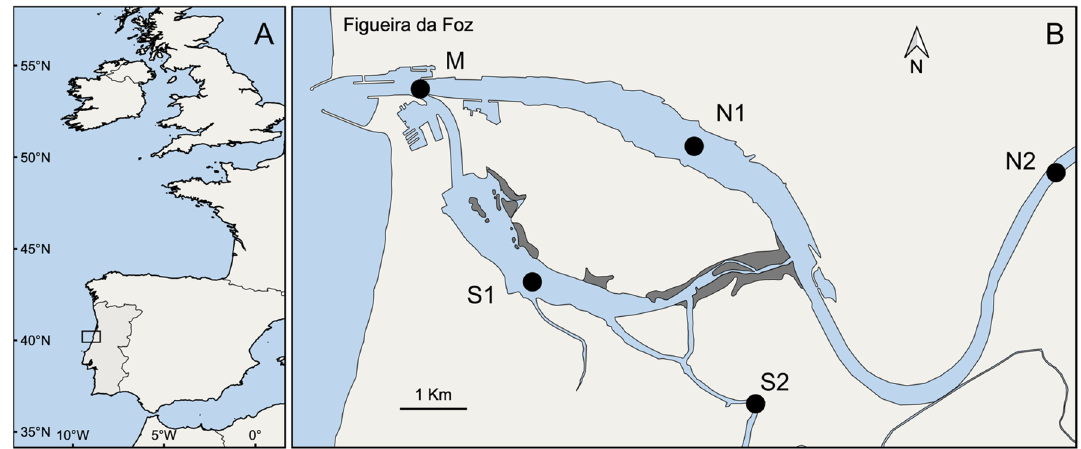
Figure 1. Geographical location of the Portuguese Atlantic coast ( A ) and the sampling stations in the Mondego estuary ( B ), denoted by the letters M, N1, N2, S1 and S2. Maps were created using QGIS 3.10.10 software (https:// qgis.